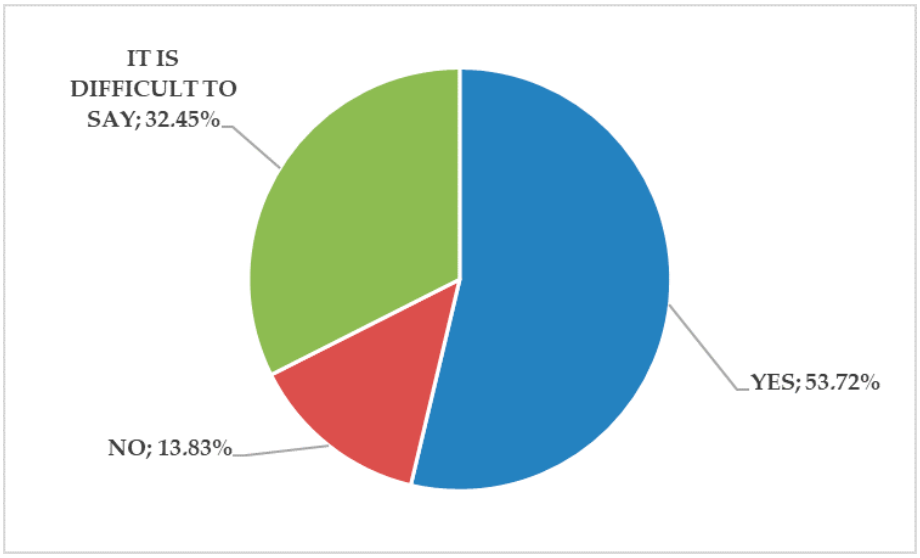
Figure 5. Distribution of responses to the question about the perception of the institute as a prestigious place to work. Source: own elaboration based on the results of questionnaire surveys.